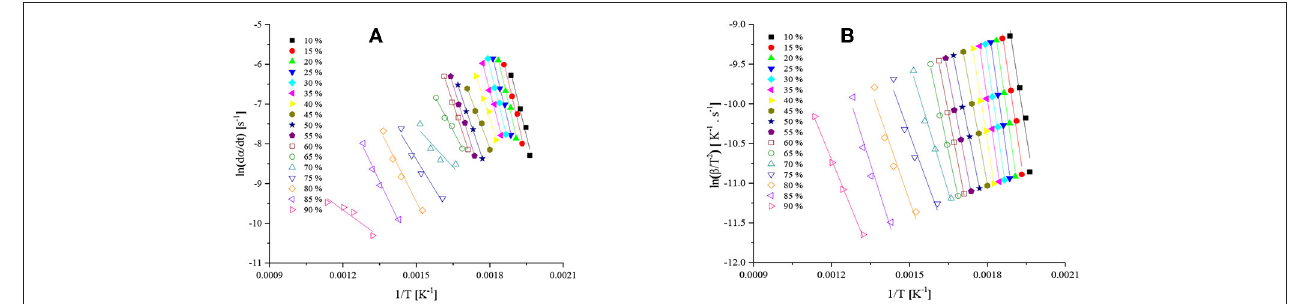
FIGURE 4 | (A) Friedman and (B) KAS graphs at the different extent of conversions.